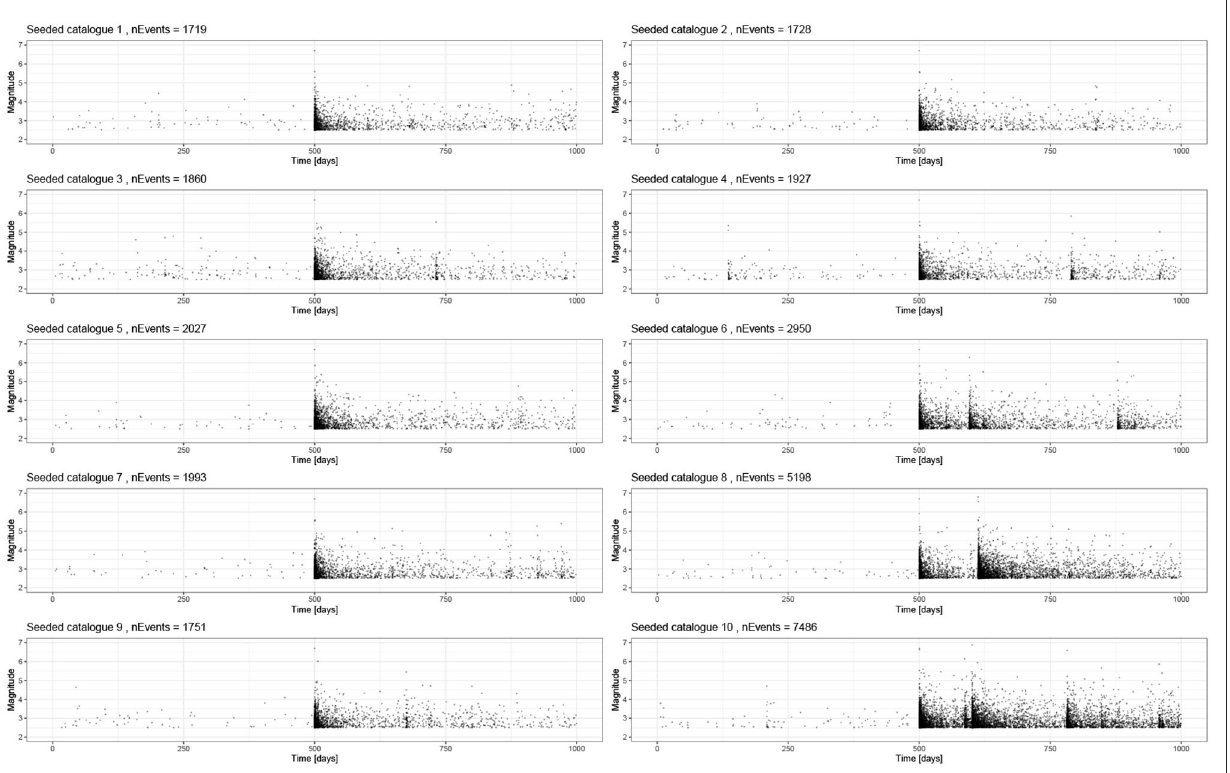
FIGURE7 A total of 10 synthetic catalogs based on the baseline model of 1,000-days with background events and an M6.7 event on day 500. All parameters are the same between the runs, and these just capture the stochastic uncertainty. These are all inverted using inlabru , and the family of posteriors is presented in Figure